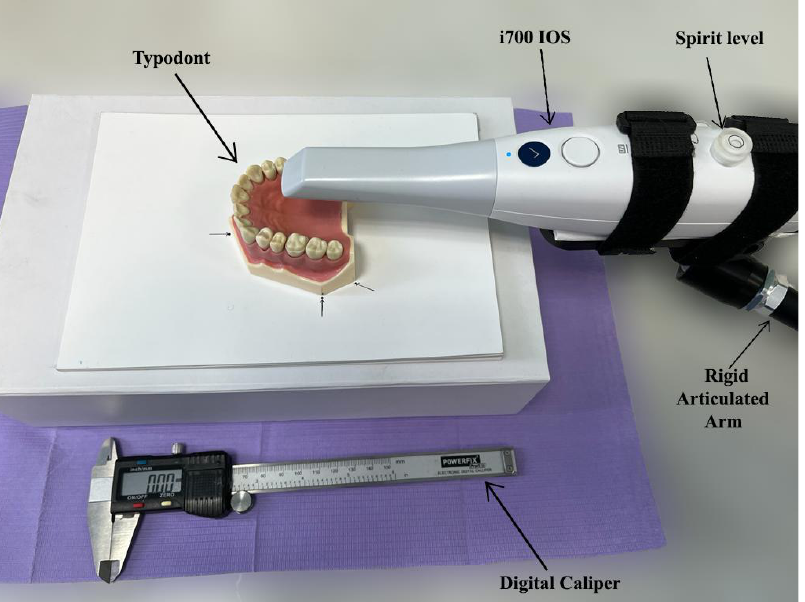
Figure 1. Visual description of the experiment setup and the instruments used in the process .